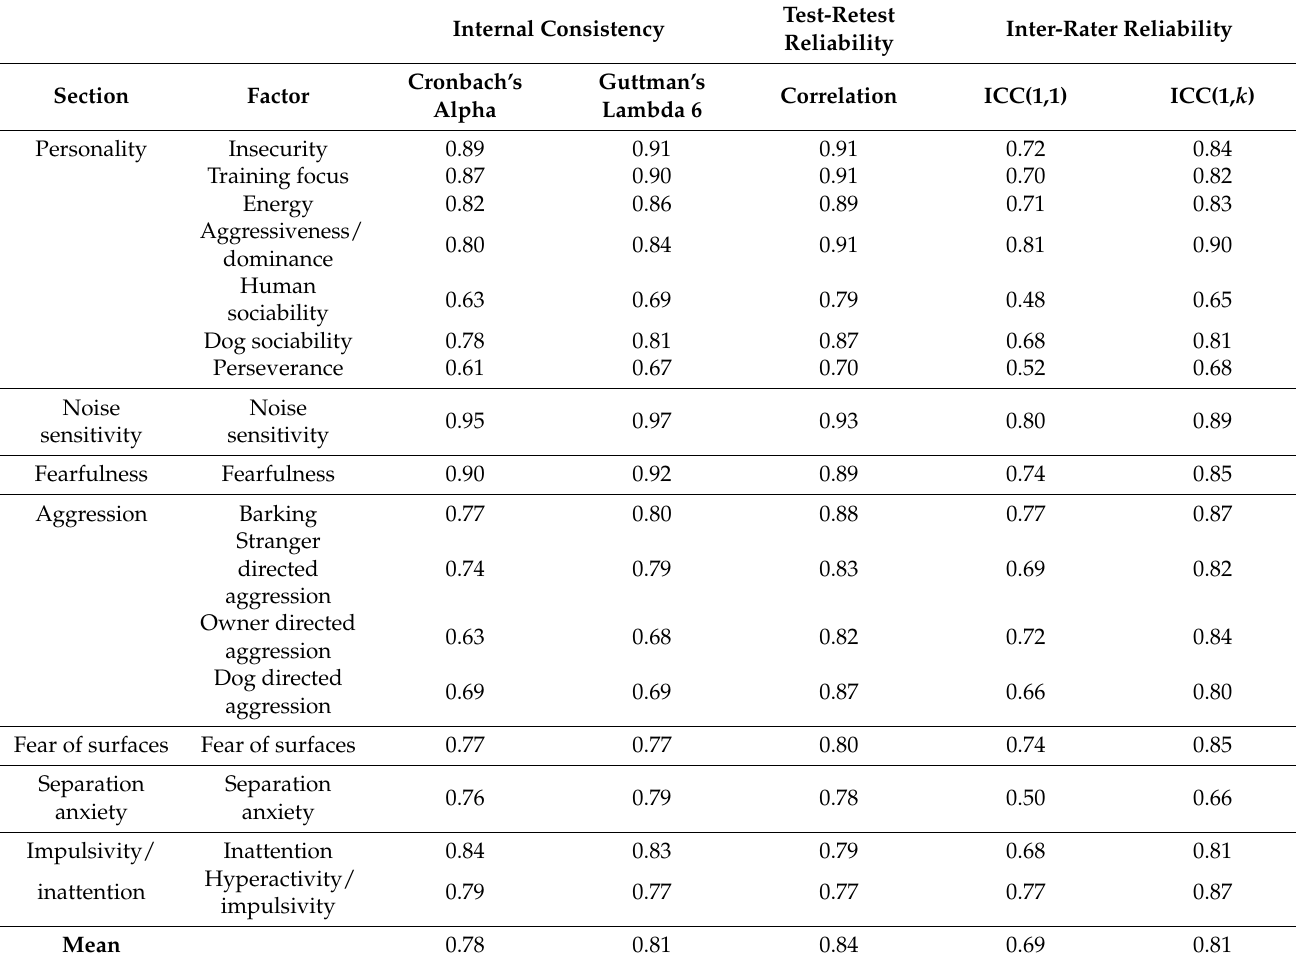
Table 3. Internal consistency, test-retest reliability and inter-rater reliability of personality and unwanted behavior factors. ICC = Intraclass Correlation